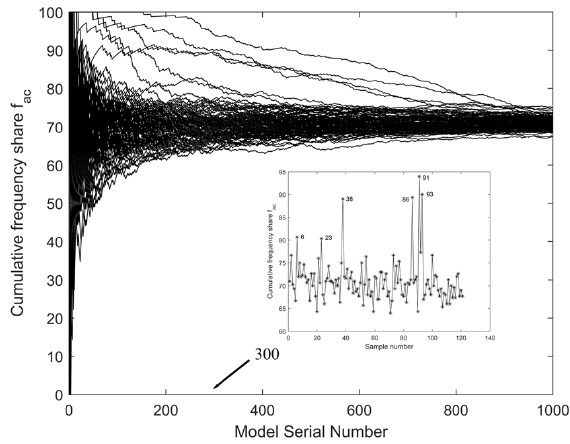
Figure 6. Cumulative frequency profile of each sample.